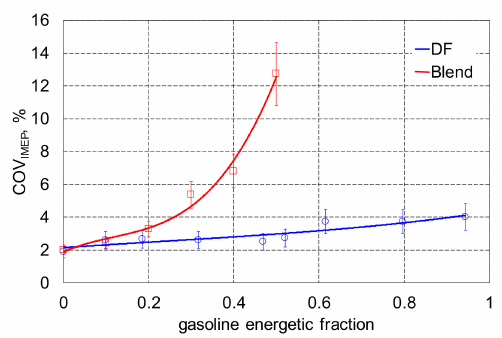
Figure 10. Cycle variation of engine powered by blend and as dual fuel